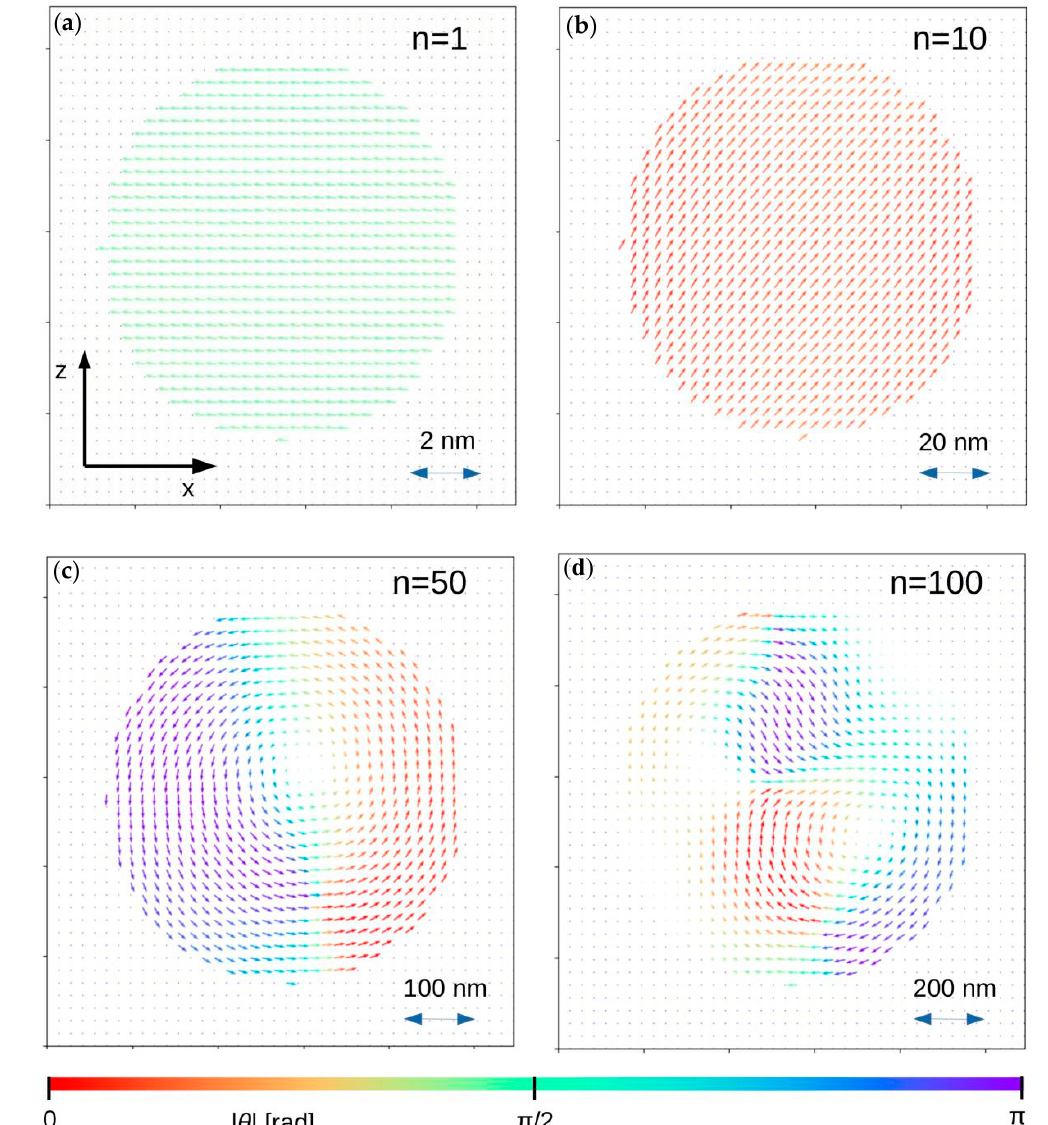
Figure 3. Magnetic moment configurations for 3D sphere in central z-x plane for different n parameters. In this figure, θ is the angle between magnetic moment direction and the z-axis . ( a ) n = 1; ( b ) n = 10; ( c ) n = 20; ( d ) n = 100.